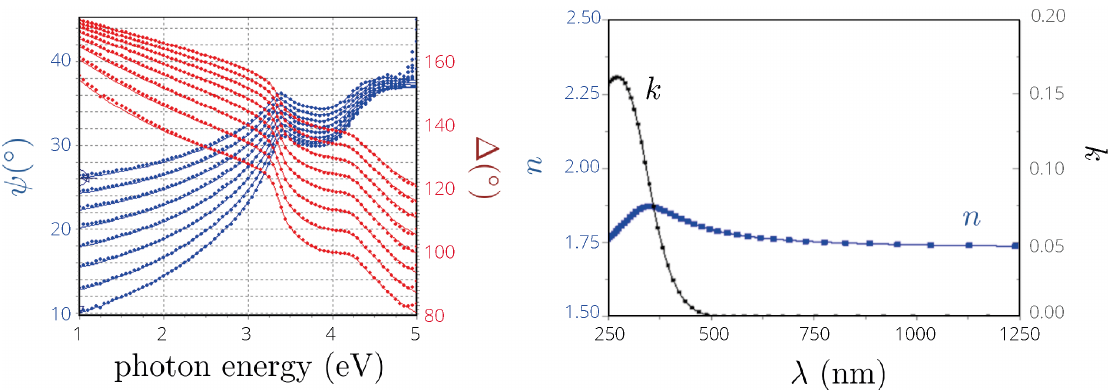
Figure 4. ( Left ): Examples of ellipsometric angles ψ and ∆ collected for eight angles over a given range of energies (symbols) and best parametrization (solid lines). ( Right ): Complex refractive index (¯ n = n + ik ) of a CeO 2 coating obtained out of these ellipsometric